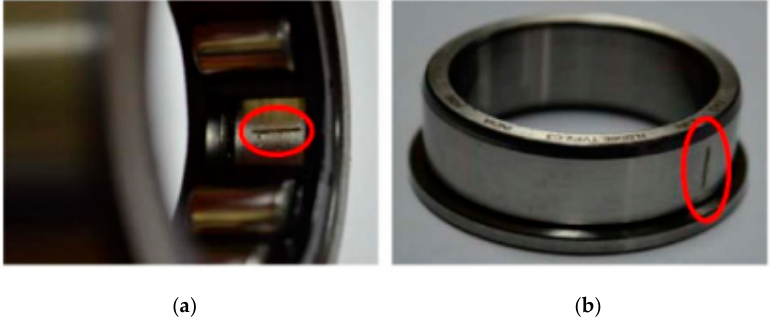
Figure 1. Bearing fault conditions. ( a ) bearing crack on the outer surface; ( b ) bearing crack on the inner surface.